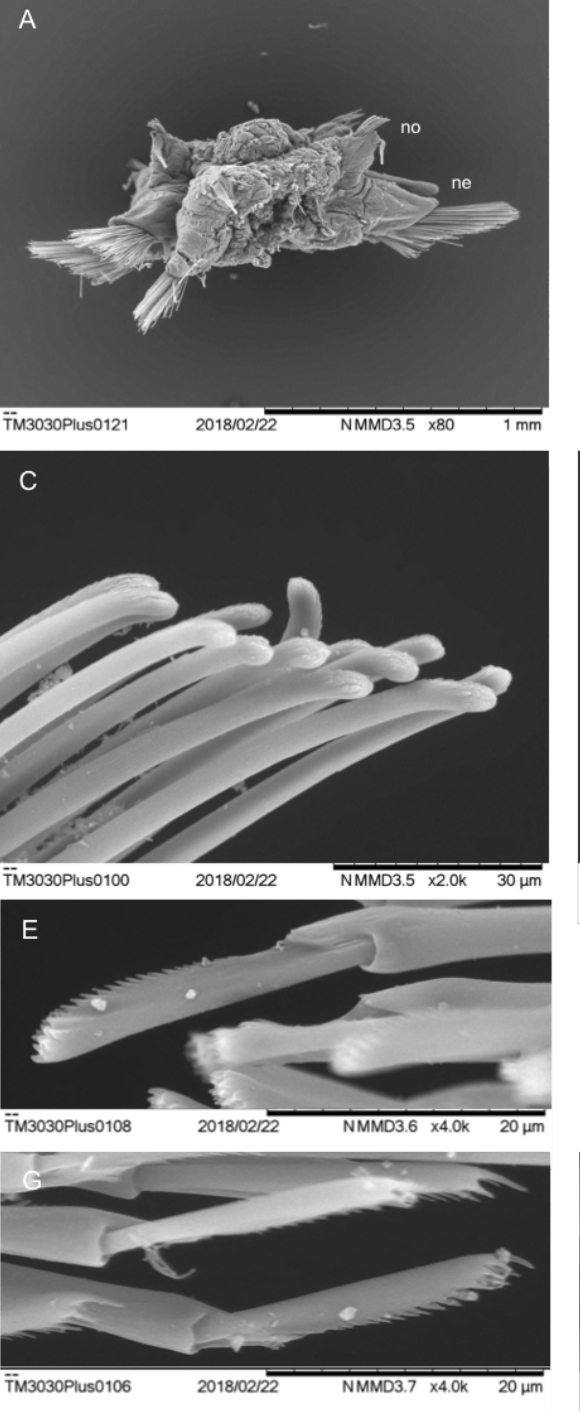
Fig. 5. Craseoschema thyasiricola gen. et sp. nov. SEM images. A . Fragment from median region, posterior view. B . Median parapodium, posterior view. C . Notochaetae of median parapodium. D . Notochaetal tips. E–F . Dorsalmost neurochaetae. G–H . Ventralmost